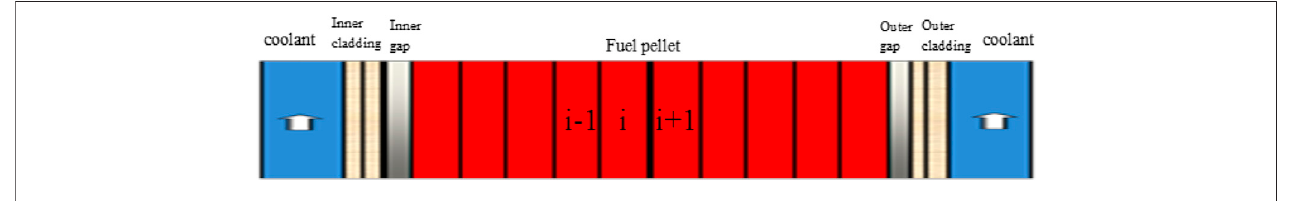
FIGURE 3 | Radial node division of annular